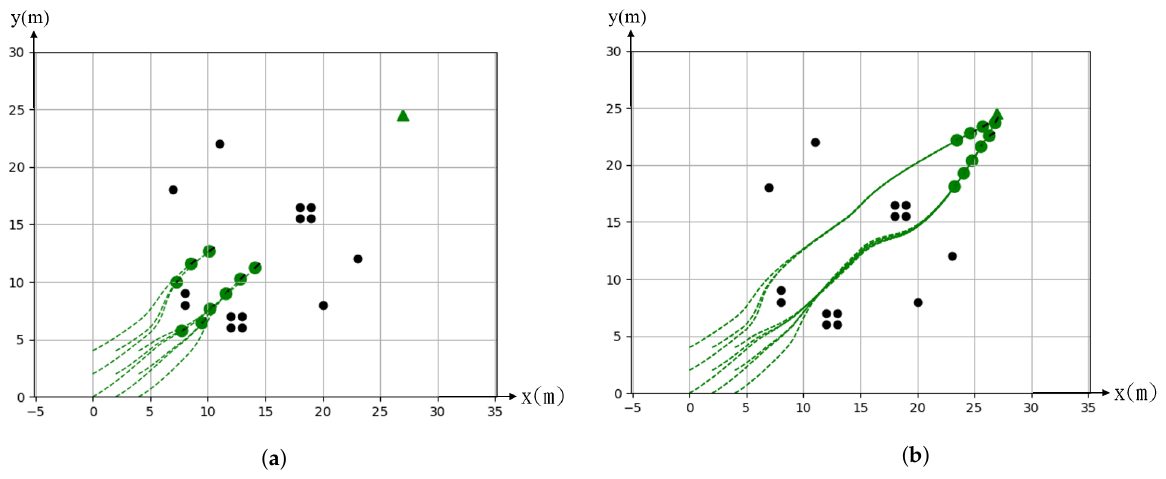
Figure 5. Simulation of static single target. ( a ) Original toward to the target. ( b ) Finally stop at the